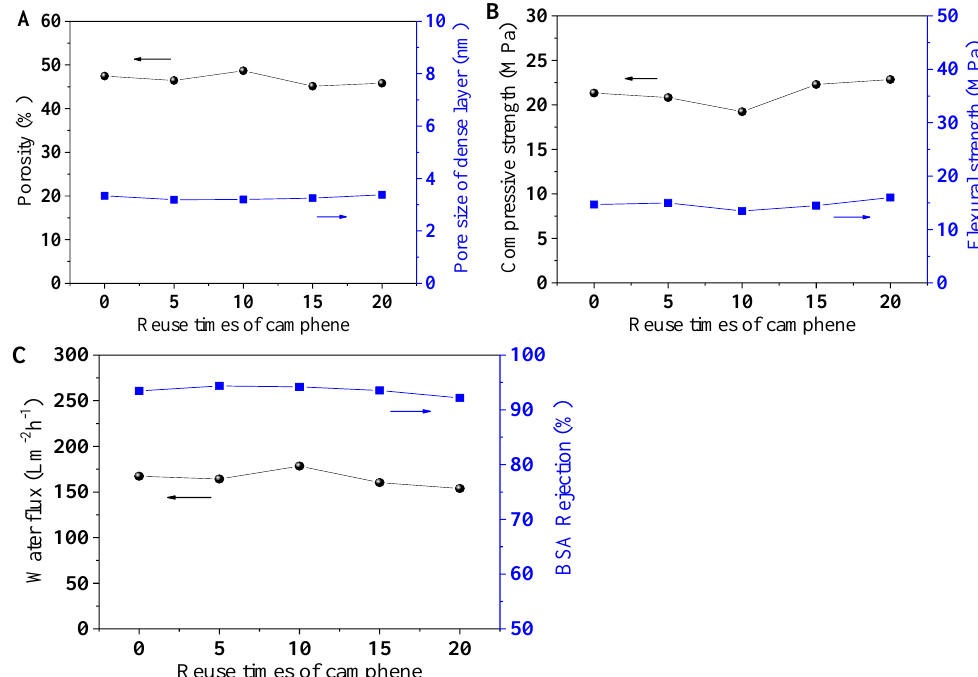
Figure 3. SEM images of PCMs’ supporting layer with different reused times of camphene under 60 wt.% solid content; ( A – E ) represent 0, 5, 10, 15 and 20 reuse times of camphene, respectively.